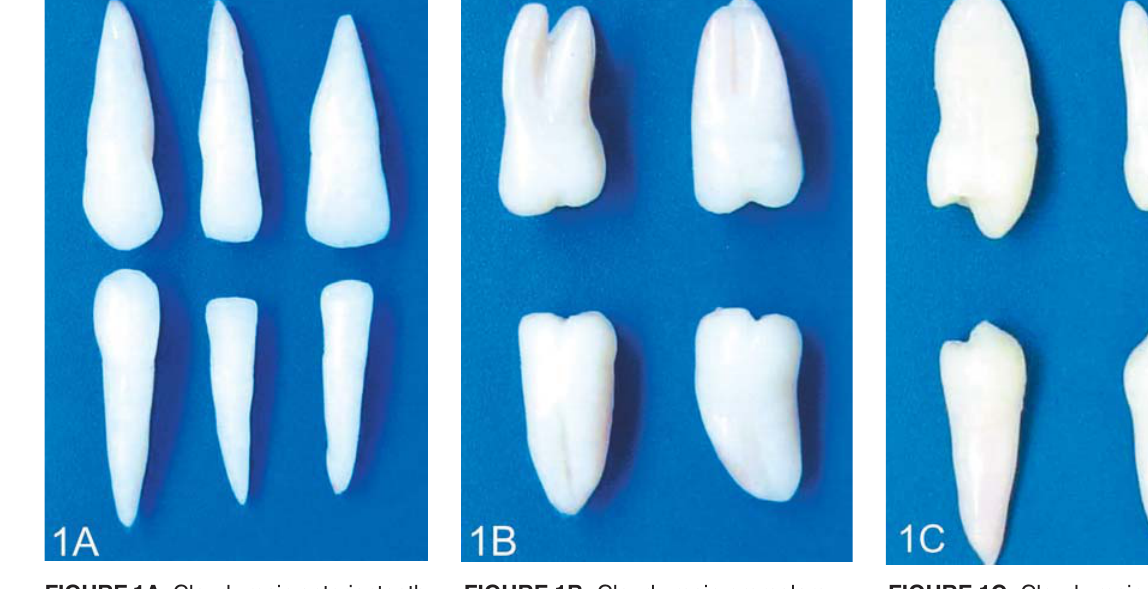
FIGURE 1A- Cloudy resin anterior teeth FIGURE 1C- Cloudy resin molars FIGURE 1B- Cloudy resin premolars